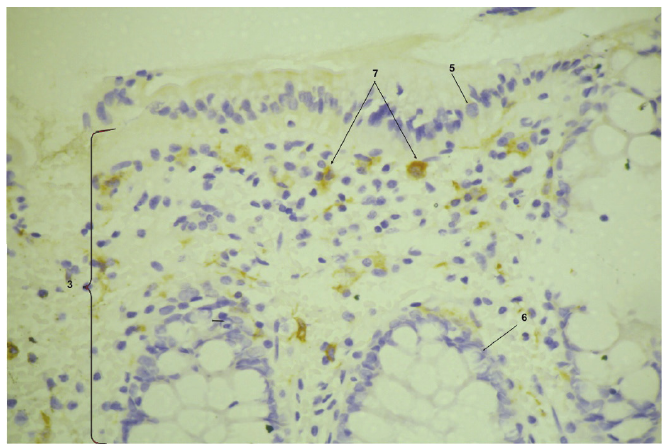
FIGURE 2 - Immunohistochemical staining of a serial section of rectum. 3 =cells of lamina propria, 5 =columnar epithelium, 6 =rectal glands, 7=DC-SIGN+DC, DC=dendritic cells.